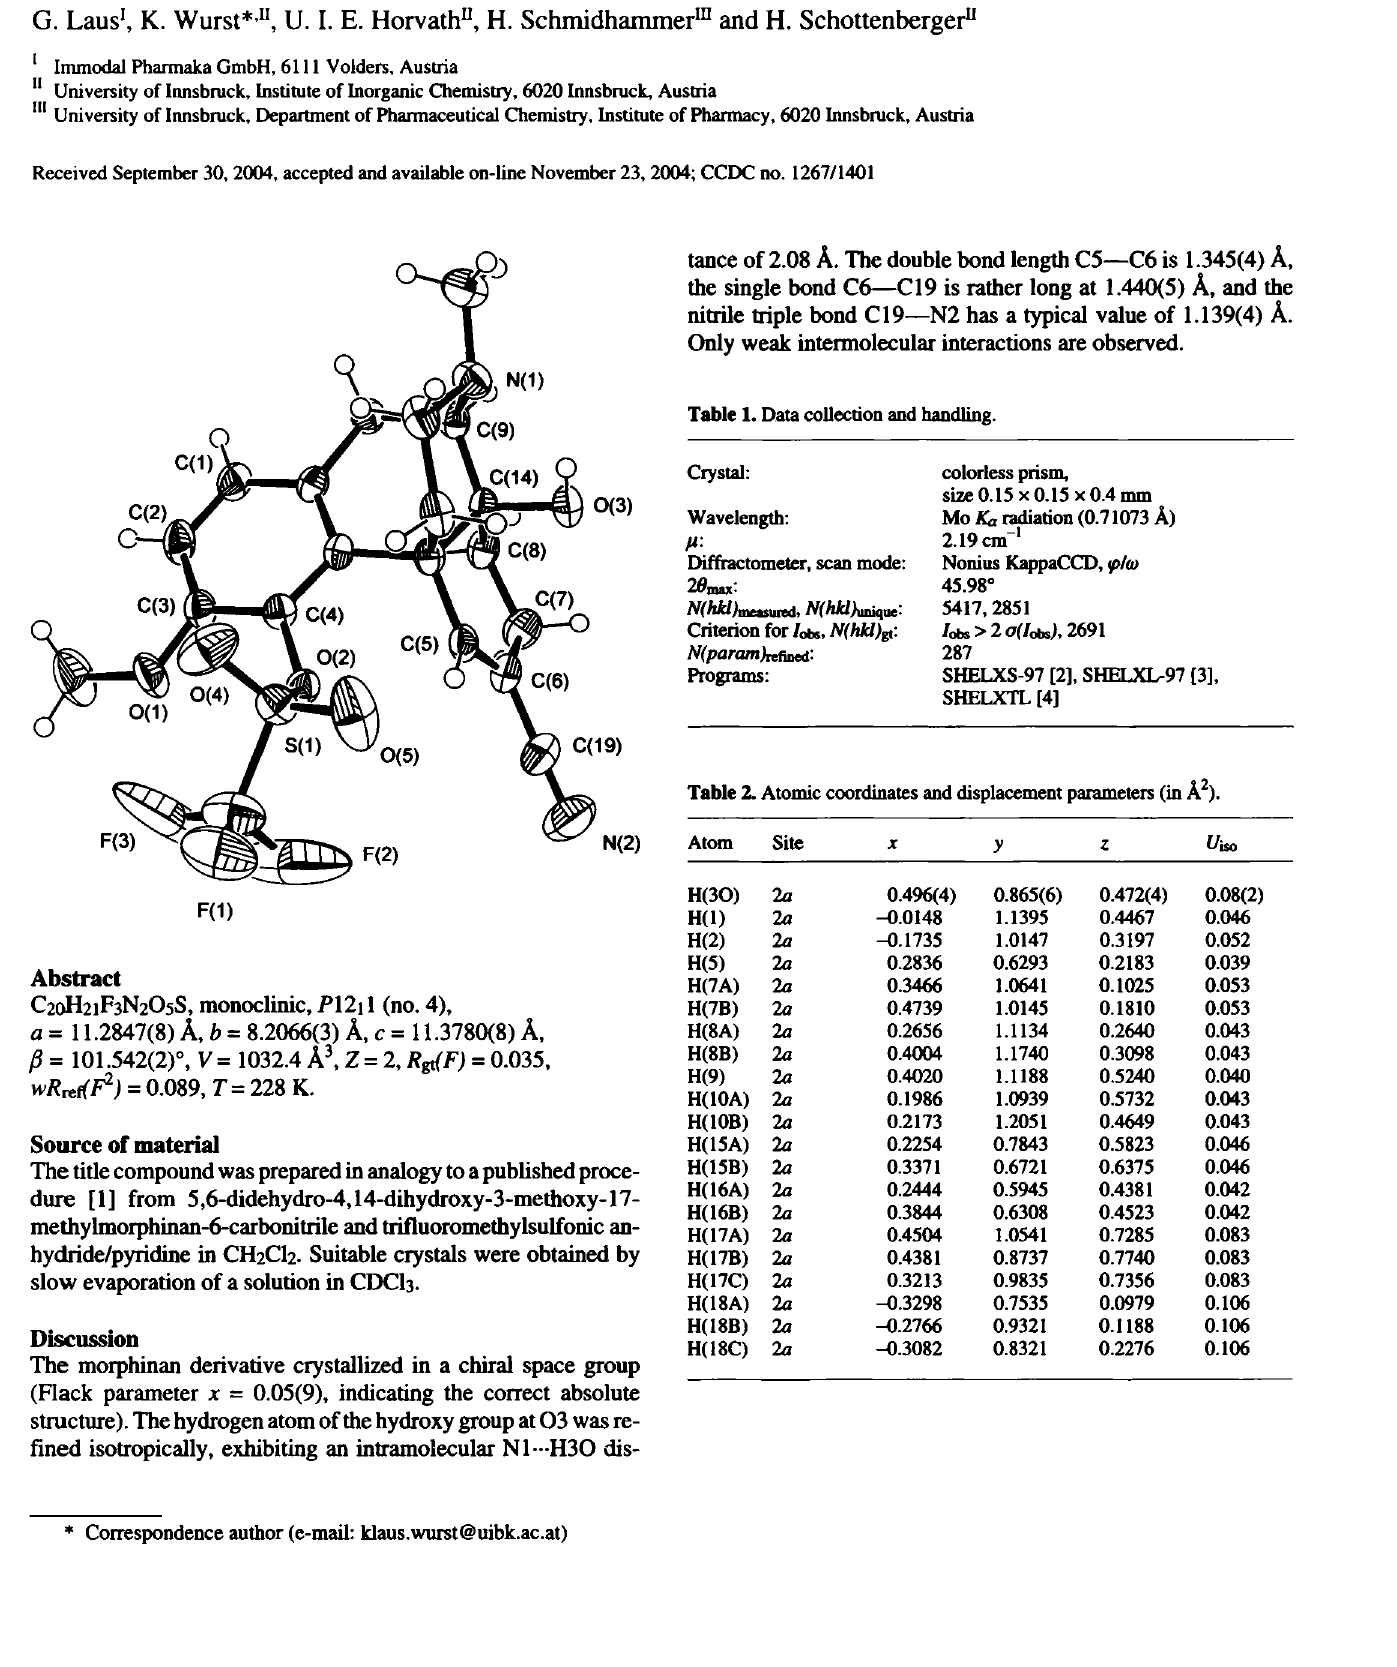
Table 2. Atomic coordinates and displacement parameters (in Â 2